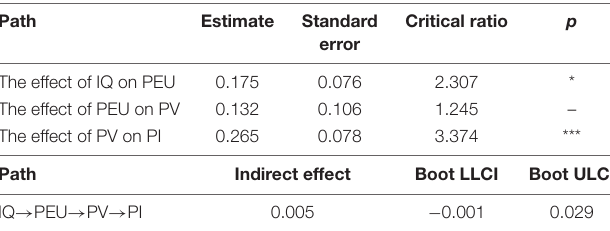
TABLE 4 | Results of path analysis 4.